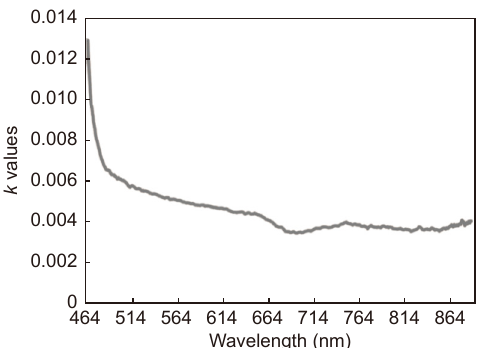
Fig. 6 | Extinction coefficient as a function of wavelength.